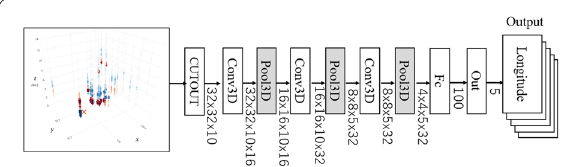
Fig. 4 Network architecture used for the 3D convolutional neural